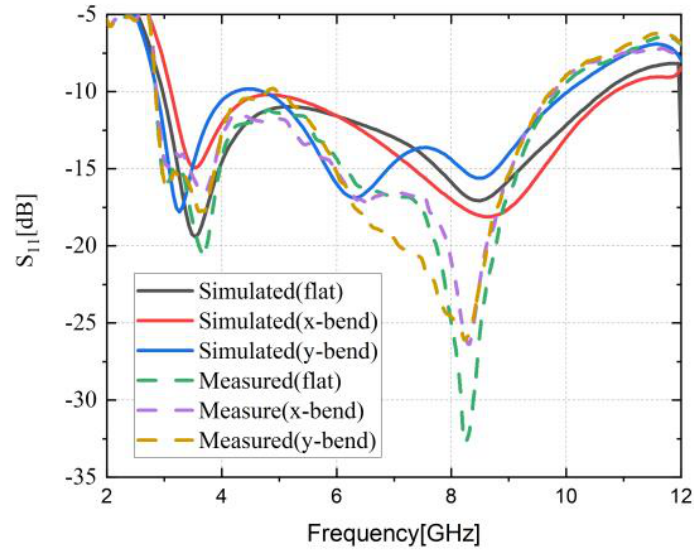
9 of 13 Figure 10. Comparison of simulated radiation patterns in free space and close to the human head at 6 GHz. 3.2. Structural Deformation The structural deformation of t he antenna must be studied to ensure the stability of the antenna. In addition, when an antenna is placed close to the head as a wearable device, bending tests should also be performed to determine whether the results of the reflection coefficient are disturbed. Figure 11 shows the two bending models for antenna measure- ments with a curvature of 2 × 10 −2 m −1 . ( a ) ( b ) Figure 11. Structural deformation ( a ) X-bend ( b ) Y-bend. Figure 12 describes the changes in return loss due to structural deformation in the X and Y directions. From Figure 12, it can be concluded that the resonance point obtained